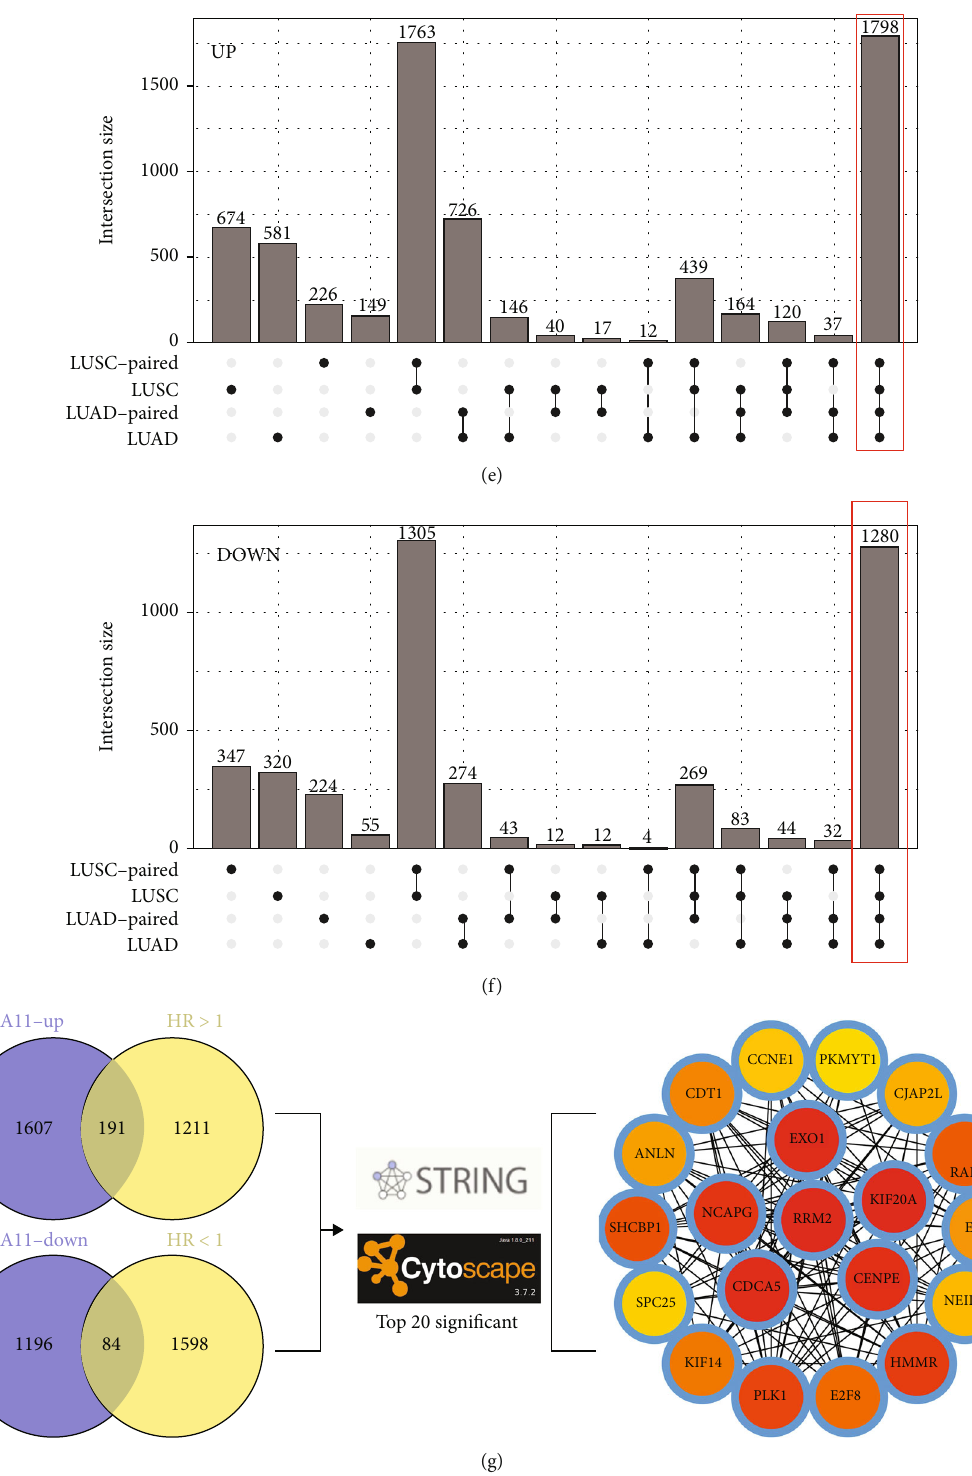
Figure 1: Identi fi cation of NEIL3 as the interested gene in our study. Notes: (a – d) DEGs analysis was performed between the tumor and normal tissues in TCGA-LUAD and TCGA-LUSC; (e) a total of 1798 genes were commonly upregulated in TCGA-LUAD and TCGA- LUSC, as well as in paired samples; (f) a total of 1280 genes were commonly downregulated in TCGA-LUAD and TCGA-LUSC, as well as paired samples; (g) top 20 key nodes of the commonly upregulated and downregulated genes based on the PPI